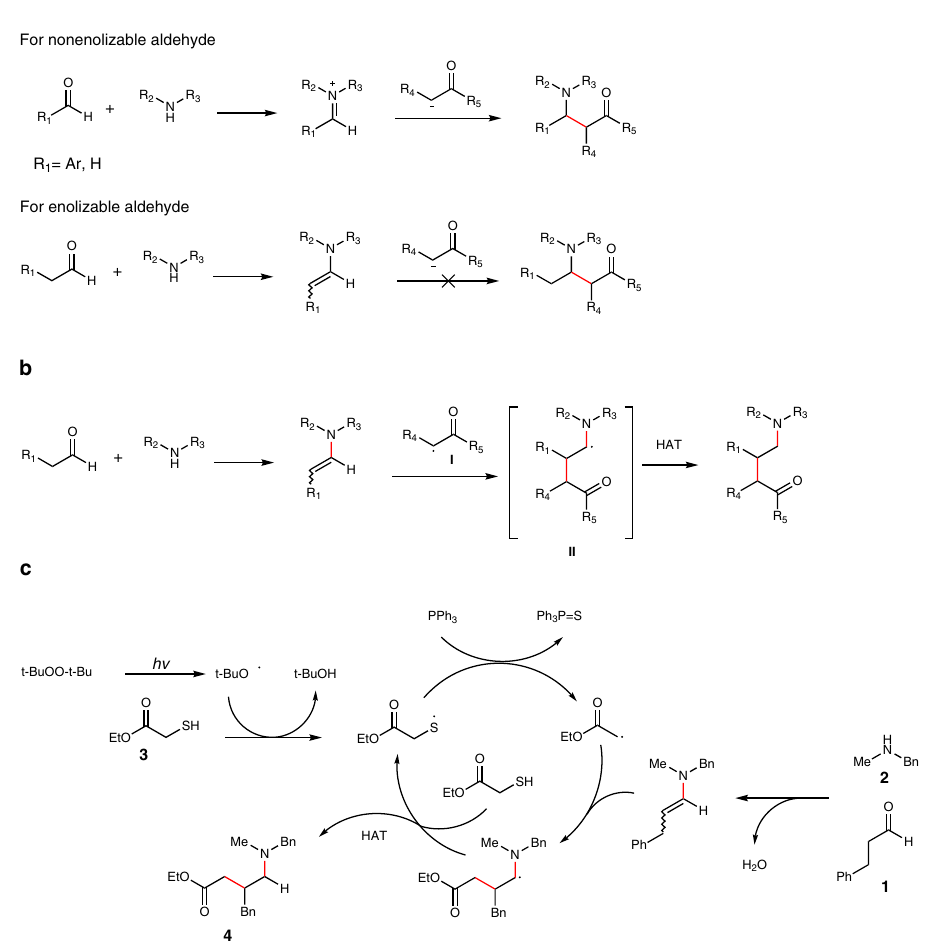
Fig. 1 Radical strategies for homo Mannich reaction. a The classical Mannich reaction. b Radical homo Mannich reaction. c Proposed mechanism for the three-component radical homo Mannich reaction. HAT hydrogen atom